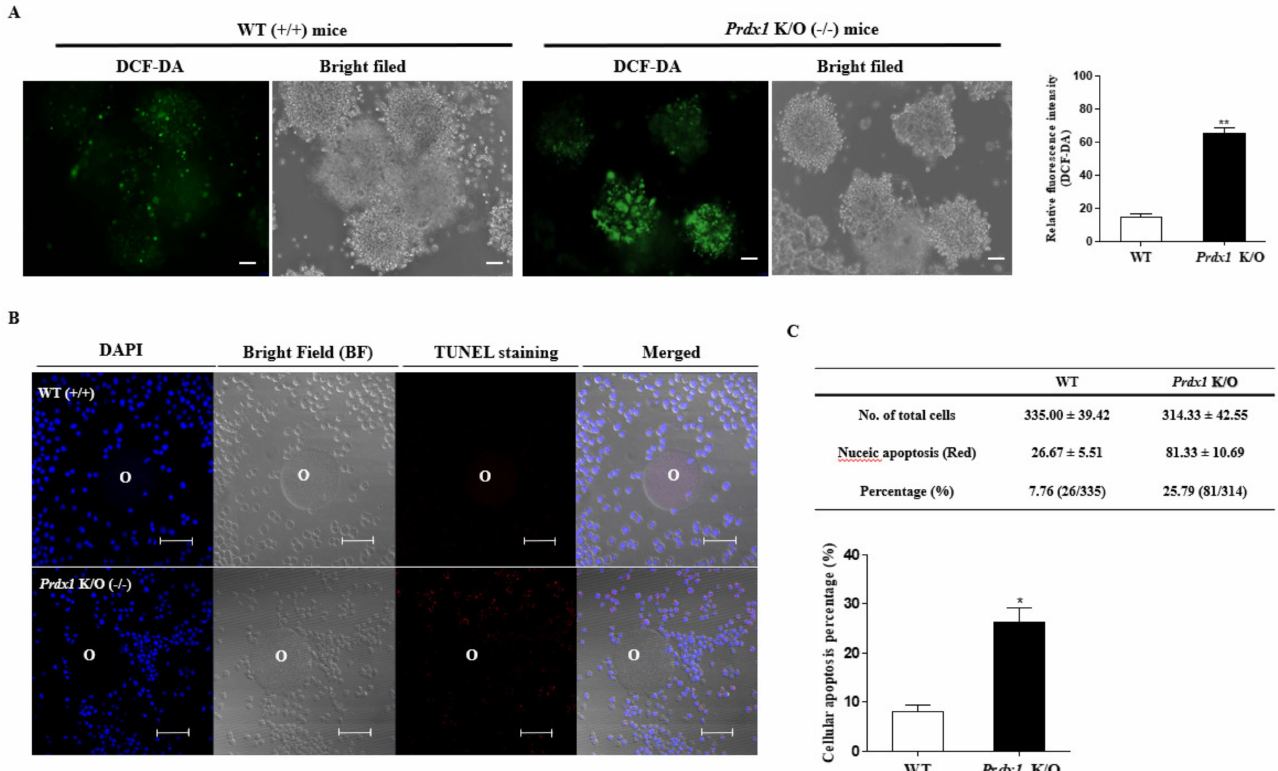
Figure 6. ROS production and cellular apoptosis according to Prdx1 gene deficiency in the ovulated COCs of Prdx1 K/O mice. ( A ) Investigation of intracellular ROS production in ovulated COCs by Prdx1 deletion. COCs of Prdx1 K/O and WT mice were incubated in a culture medium (M16, Sigma) with 1.0 µ g/mL DCF-DA for 15 min (scale bar = 50 µ m). ( B , C ) Detection of cellular apoptosis in CCs of ovulated COCs in Prdx1 K/O mice, with Hoechst 33342 staining identifying nuclei, TUNEL staining identifying apoptotic cells, and a merged photograph of Hoechst 33342 and TUNEL-stained ovulated COCs (20 × ; scale bar = 50 mm) of Prdx1 K/O mice. The quantification of fluorescence intensity in DCF-DA- and TUNEL-stained COCs was obtained using the Image J program. Data in the bar graph represent the means ± SD of three independent experiments. *, p < 0.05; **, p < 0.01 compared with WT